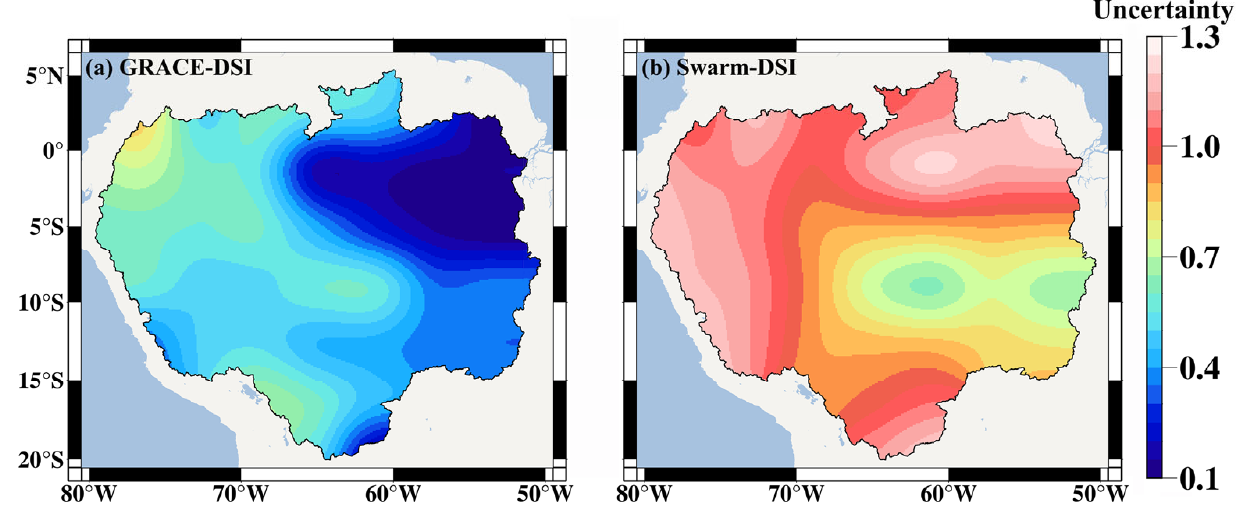
Figure 6. The time series of drought indices form GRACE and Swarm models in the ARB from 2014 to 2019.